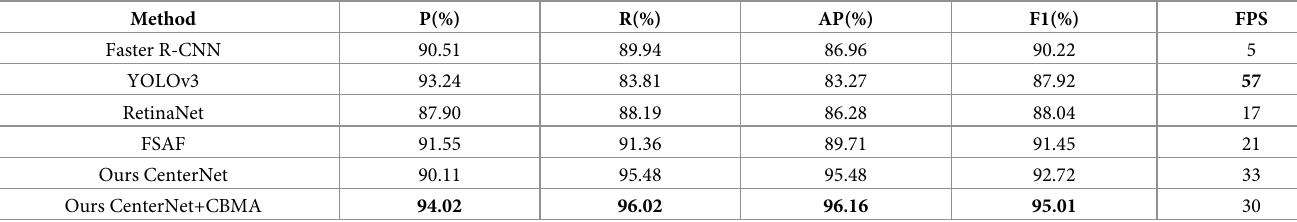
Table 1. Main detection